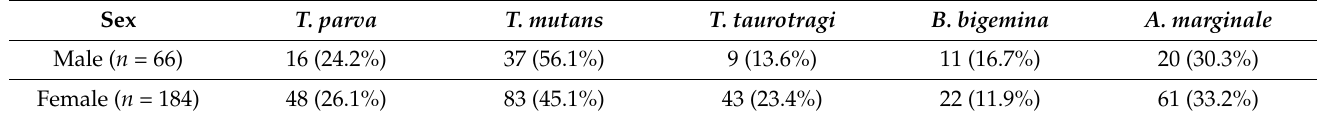
Table 4. The prevalence of tick-borne pathogens detected, based on the animal’s sex.